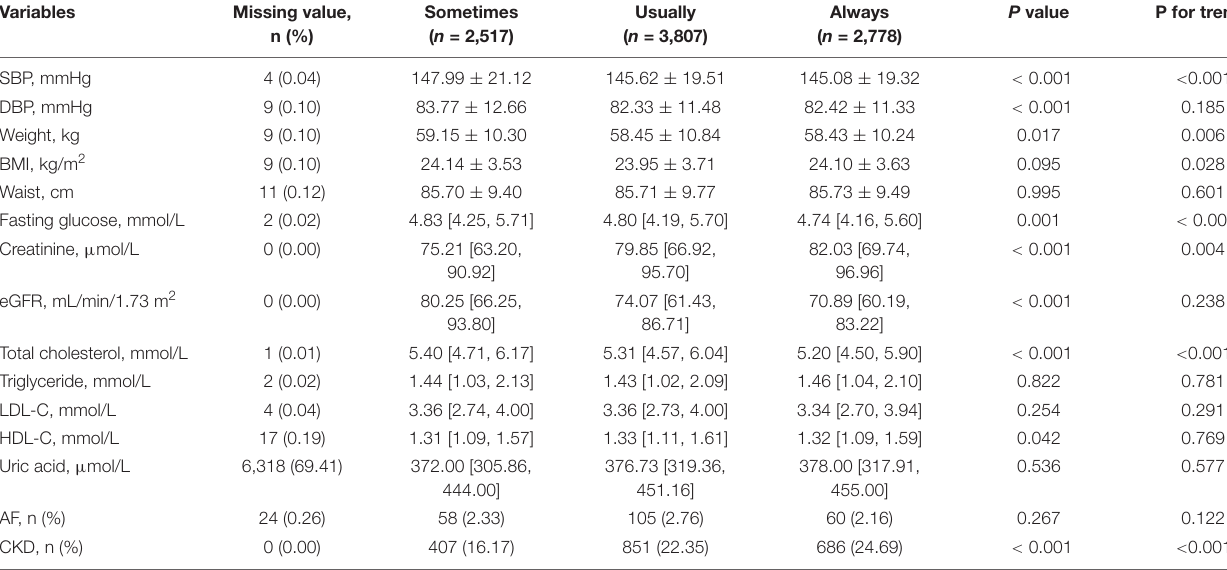
TABLE 2 | Cardiovascular risk factors stratified by health check